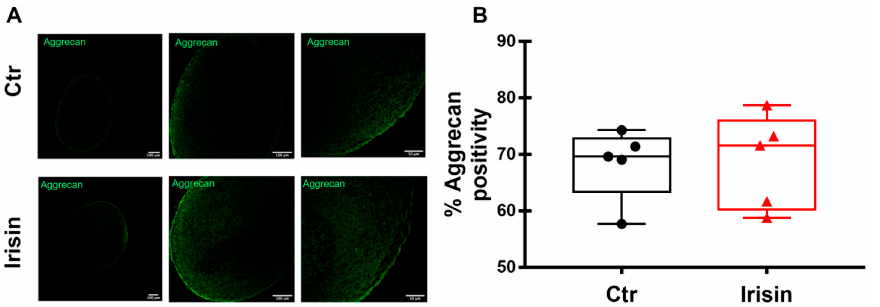
Figure 6. Immunofluorescence staining of Aggrecan ( A ) in HAC pellets, treated with Irisin and Ctr, after 21 days of chondrogenic differentiation. The figures are representative of 5 separate experiments. Dot ‐ plot graphs showing the quantification of % positivity of Aggrecan ( B ). Data are shown as box ‐ and ‐ whisker plots with median and interquartile ranges, from max to min. A Mann–Whitney test was used to compare the groups.